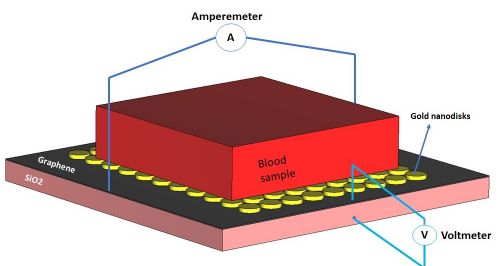
Figure 13. A graphical screen of the proposed nanosensor with electronic contacts, including volt- meter and amperemeter, attached to the